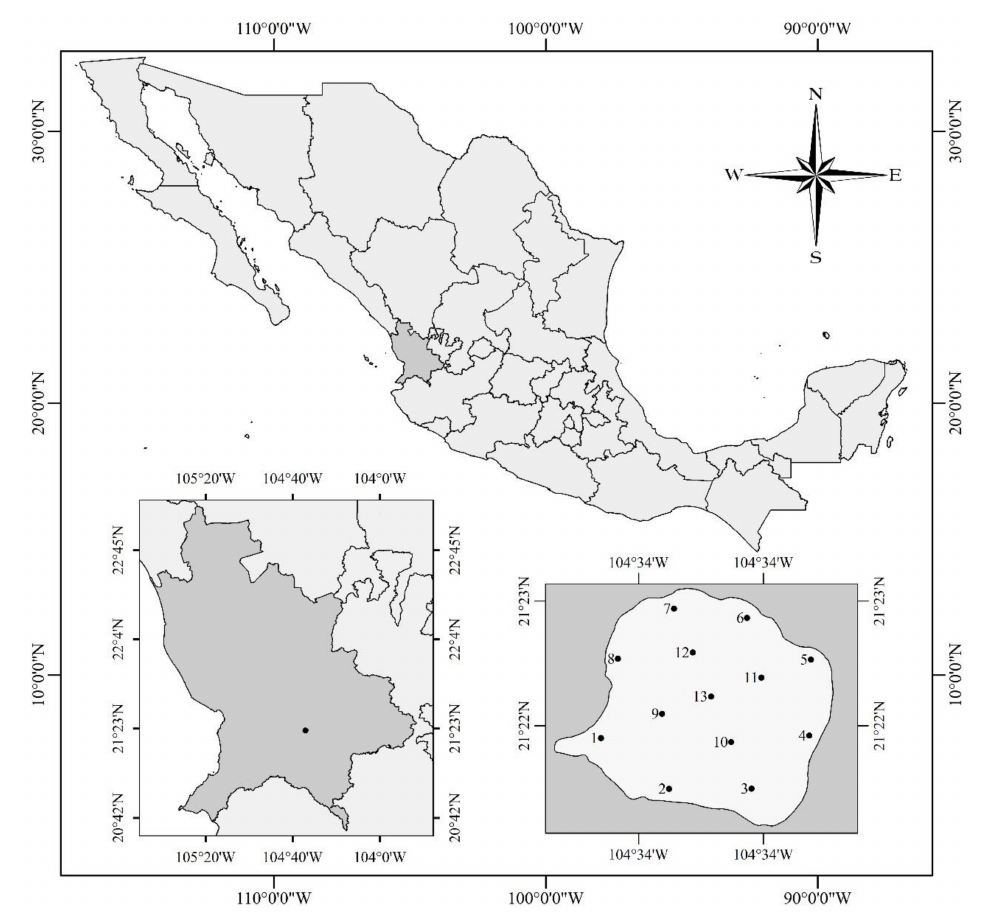
Figure 2. Location of Santa Mar í a del Oro lake in the state of Nayarit (black point in the left figure) and sampling stations (numbers in the right